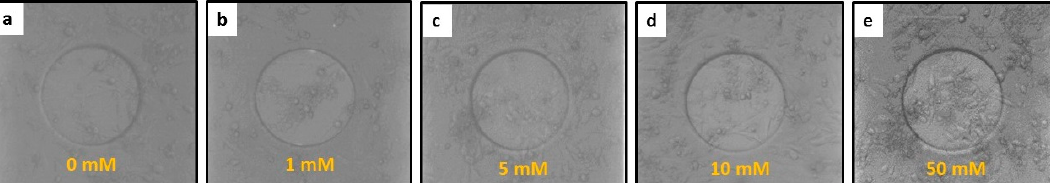
Figure 3. Images of live and dead hFOB 1.19 osteoblast cells on microfabricated electrodes after treatment with different concentrations of Mg(OH) 2 NPs at 24 h: ( a ) 0 mM Mg(OH) 2 (control group); ( b ) 1 mM Mg(OH) 2 ; ( c ) 5 mM Mg(OH) 2 ; ( d ) 10 mM Mg(OH) 2 ; and ( e ) 50 mM Mg(OH) 2 .